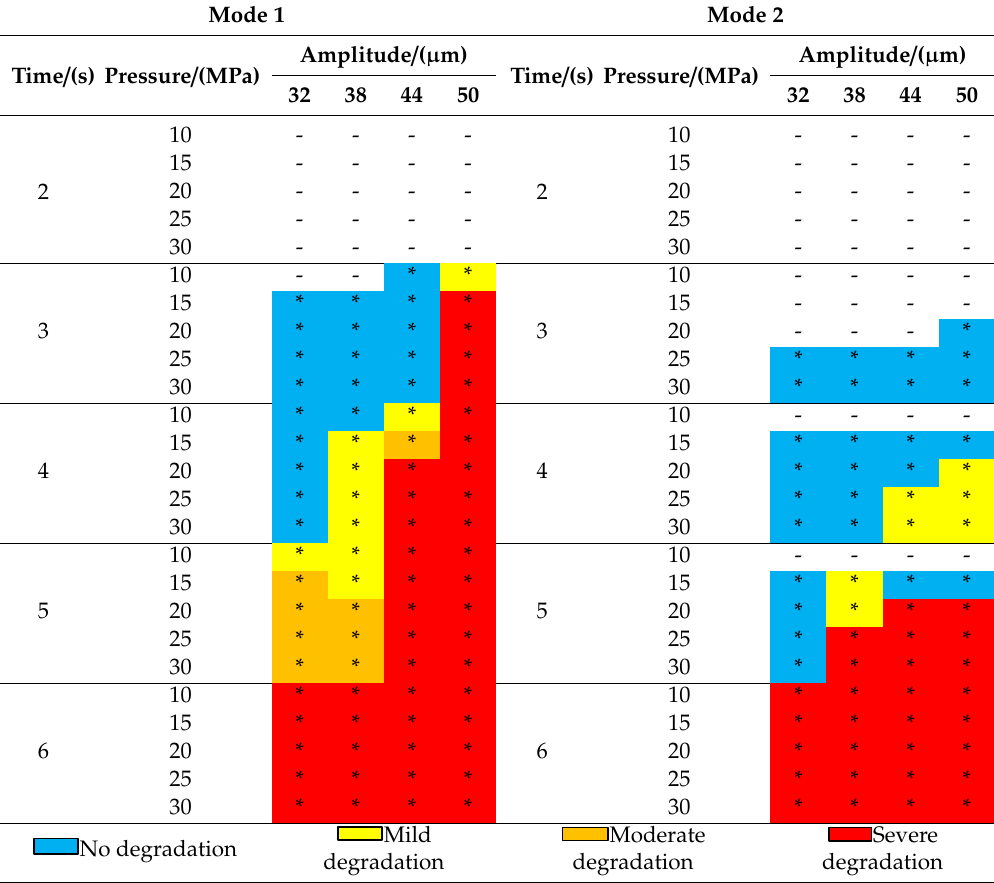
Table 5. Design of the parameter combinations of the preliminary experiment and the results under Mode 1 and Mode 2.